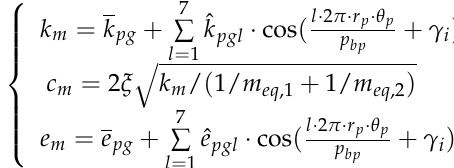
where ˆ k pgl and k pg are the l th harmonic term amplitude and mean mesh stiffness, respec- tively. ˆ e pgl and e pg are the l th harmonic term amplitude and mean transmission error, respectively. γ i is the phase angle. θ p and p bp denote the rotational angular displacement around the z -axis of gear p , and the base pitch of gear p , respectively. ξ is the damping ratio. m eq ,1 and m eq ,2 are the equivalent qualities of the gears. Shafting elements. The rotating components (such as shafts and gears) of the Figure 5. Timoshenko beam. Figure 5. Timoshenko beam.